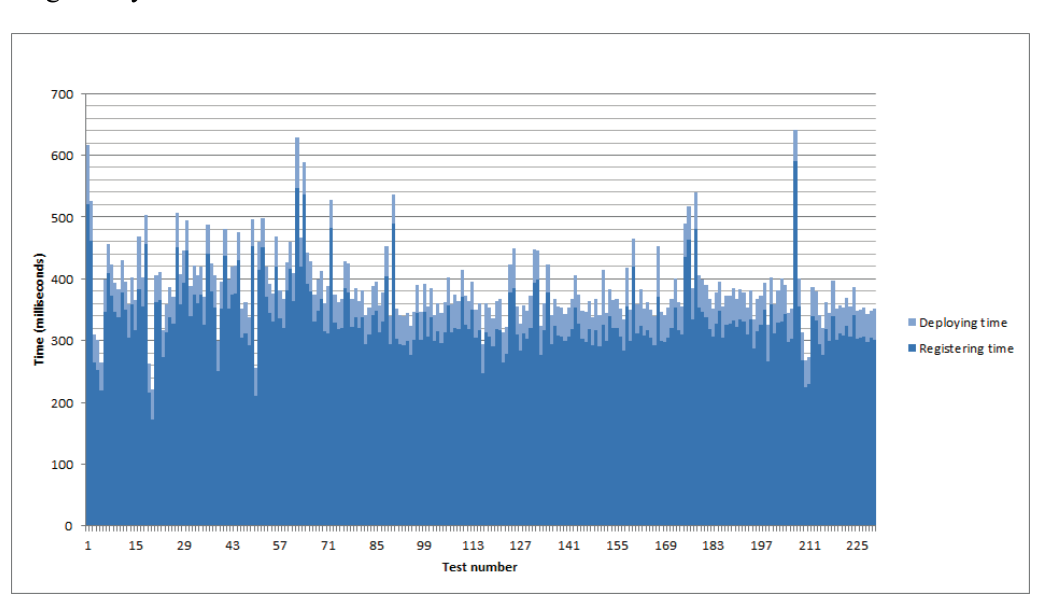
Figure 5. Time required getting a virtual representation of an existing event source in the